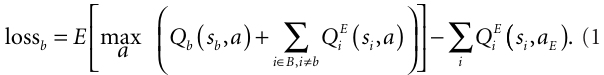
virtual avatar walking along a sidewalk strewn with litter and obstacles. The red disk marks the state estimate uncertainty for each of them for a particular moment in the